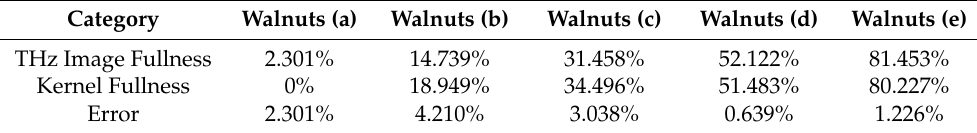
Table 6. Fullness of walnut kernels in transmission and physical